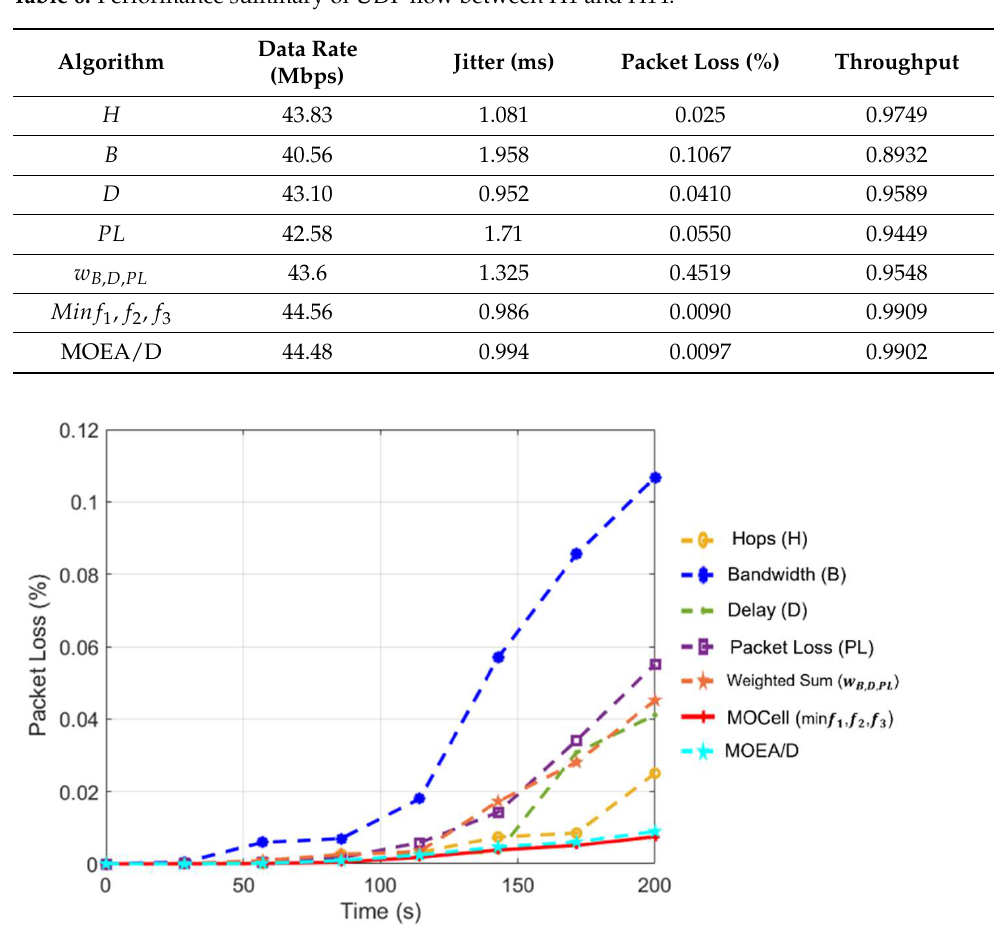
Table 6. Performance summary of UDP flow between H1 and H14.